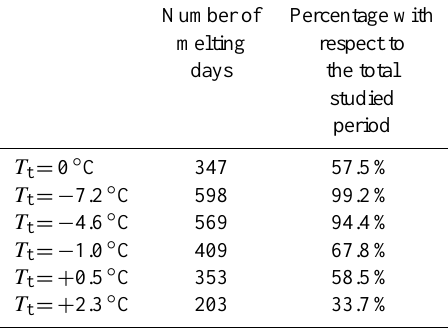
Table 3. Number of days featuring melting (i.e., at least 1 M 3C hd − 1 ) and the percentage with respect to the 602 total melt- ing